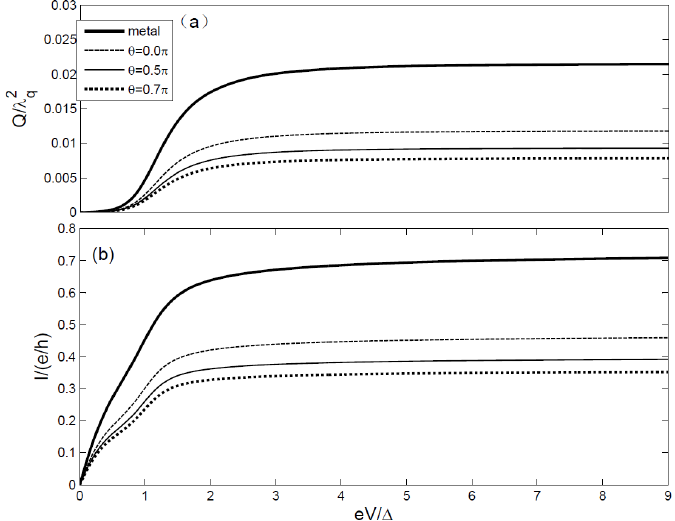
Figure 2. ( a )The heat generation Q versus the source-drain bias eV with different polarization angles θ . ( b ) The current I versus the source-drain bias eV with